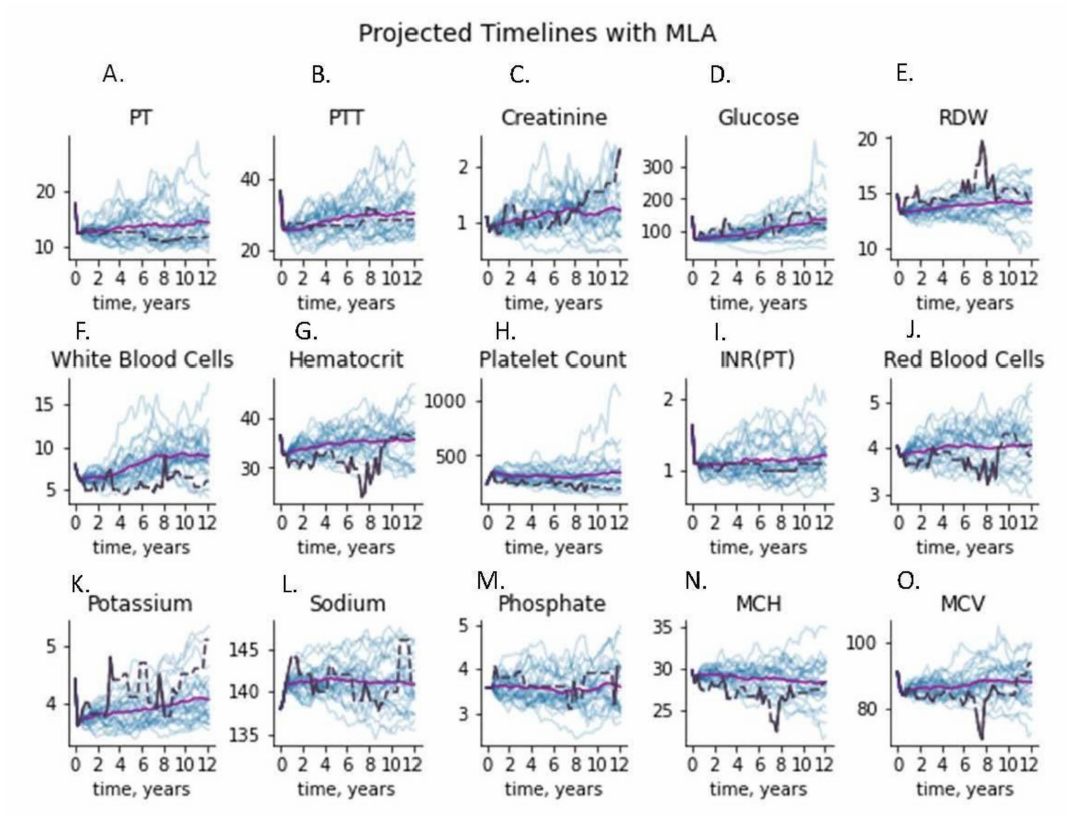
Figure 5. Time series plots for a test patient’s features, using 25 simulated patient trajectories generated from the